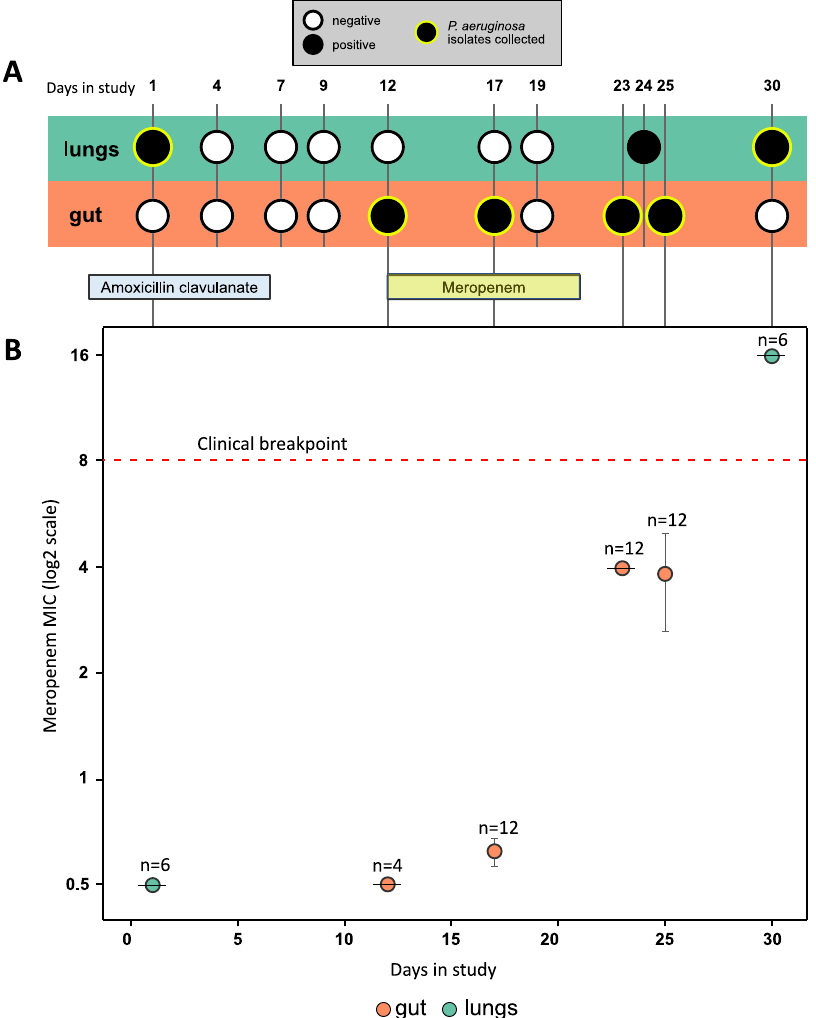
Fig. 1 | Clinical timeline and resistance phenotyping. A Timeline of patient sampling, showing samples that tested positive or negative for P. aeruginosa colonisation by culturing. Sampling points from which isolates were collected are highlighted with a green ring. The patient was treated with amoxicillin clavulanate from2dayspriortoenrolmentuntilday6andwithmeropenemfromday12today 21. B Meropenem minimum inhibitory concentration (MIC) (mean±s.e.m μ g/mL) for isolates ( n =4 – 12, as labelled on plot) from each sampling point from the gut